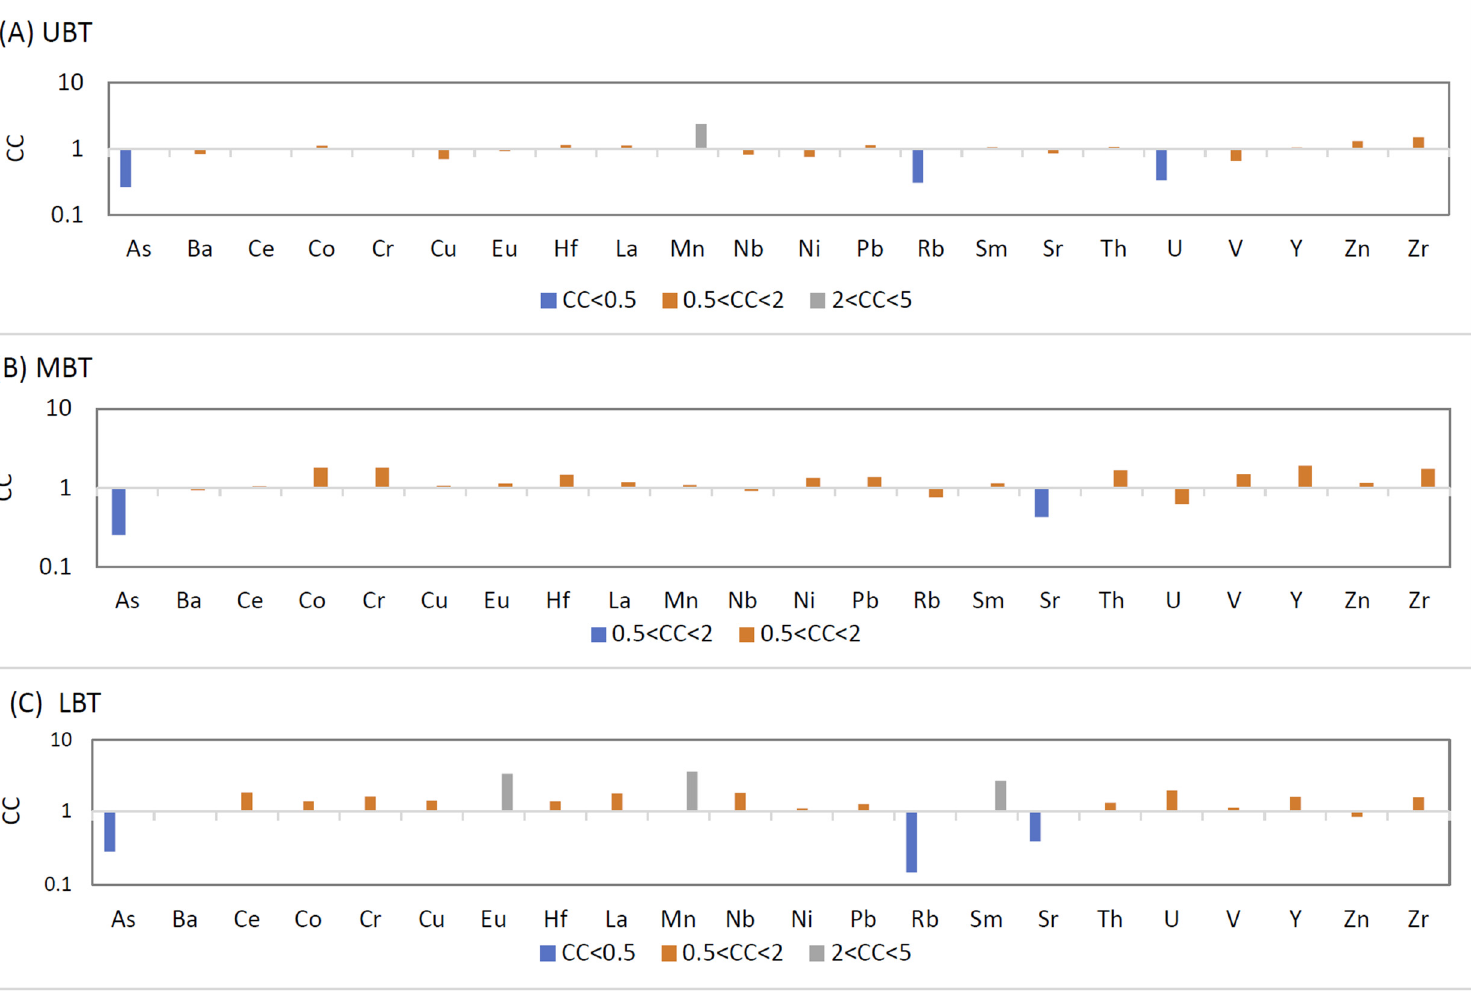
Figure 22. Concentration coefficients (CC) for trace elements in the Benue Trough coals (using data averaged from Table 8). Total hard coal data are from Ketris and Yudovich [70]: ( A ) UBT; ( B ) MBT; ( C ) LBT.